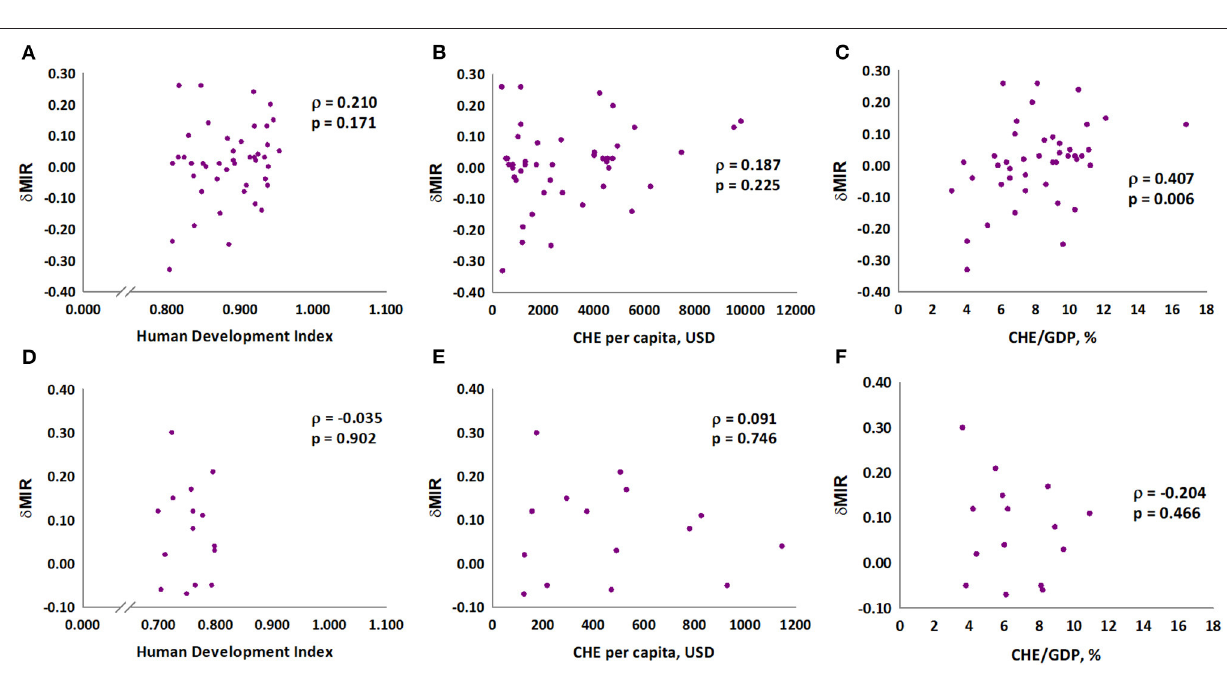
FIGURE 2 | Association between human development index (HDI), current health expenditure per capita, current health expenditure as percentage of gross domestic product and delta mortality-to-incidence ratio in gastric cancer in very high HDI countries (A–C) and others (D–F)